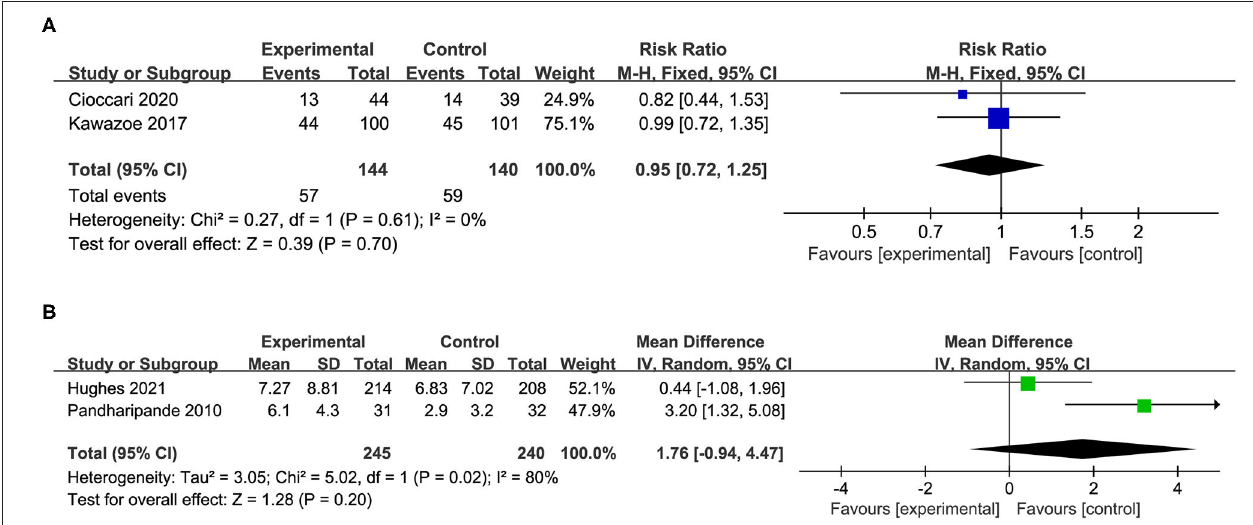
FIGURE 6 | Forest plot comparing the effect of DEX on (A) incidence of delirium, (B) delirium free